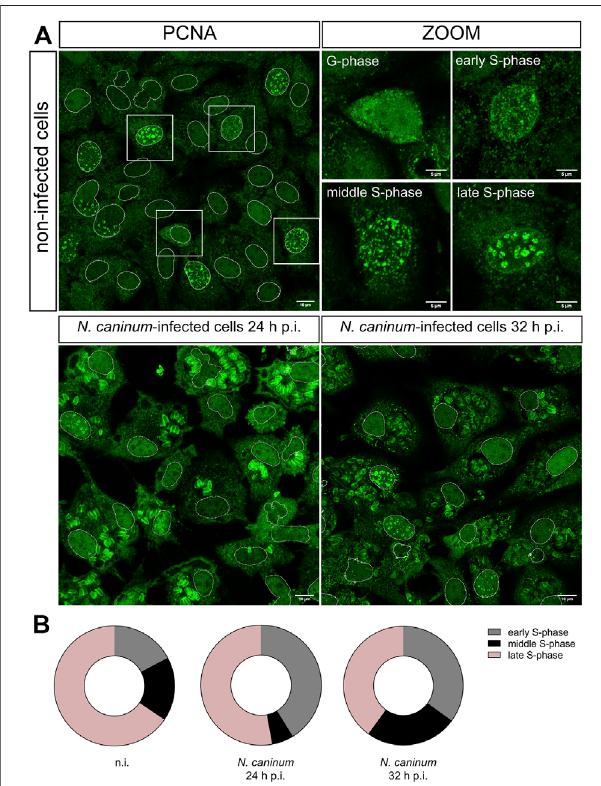
FIGURE 3 | Effects of N. caninum infection on S-subphases. (A) N. caninum -infected BUVEC and non-infected cells were fi xed at 24 ad 32 h p. i and stained for DAPI and proliferation cell nuclear antigen (PCNA; green) and analyzed via confocal microscopy. The nuclear PCNA localization and pattern allow one to discriminate the S-phase steps (early, middle, and late). The host cell nuclei were automatically segmented on the DAPI channel, the nuclear region was selected, and the coordinates were overlayed into the PCNAchanneltoidentifythenuclearzone(whitecirclesaroundthenuclei). (B) Quanti fi cation of nuclear PCNA-related pattern in non-infected cells in comparison with N. caninum- infected cells at 24 and 32 h p. i. The graph represents the percentages of cells in each S-phase step, early (gray), middle (black), and late (pink). The scale bar represents 5 µm.